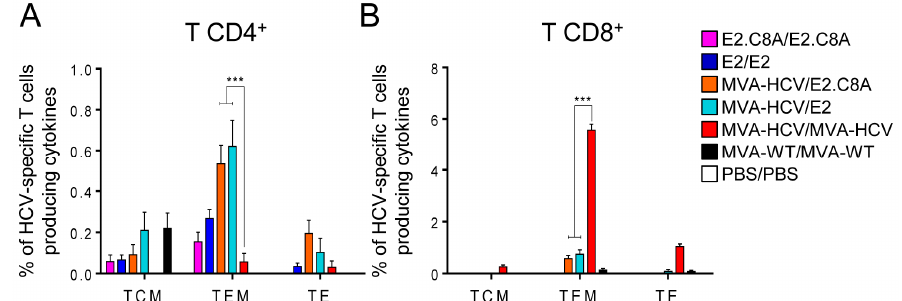
Figure 6. Memory phenotype of T cell immune responses in immunized mice. Phenotypic profiles of splenocytes from the memory phase ( n = 4 mice per group) were analyzed by Intracellular Cytokine Staining (ICS) assay. Graphs indicate the percentages of CD4 + (left) and CD8 + T (right) central memory (TCM; CD127 + CD62L + ), e ff ector memory (TEM; CD127 + CD62L − ), and e ff ector (TE; CD127 − CD62L −